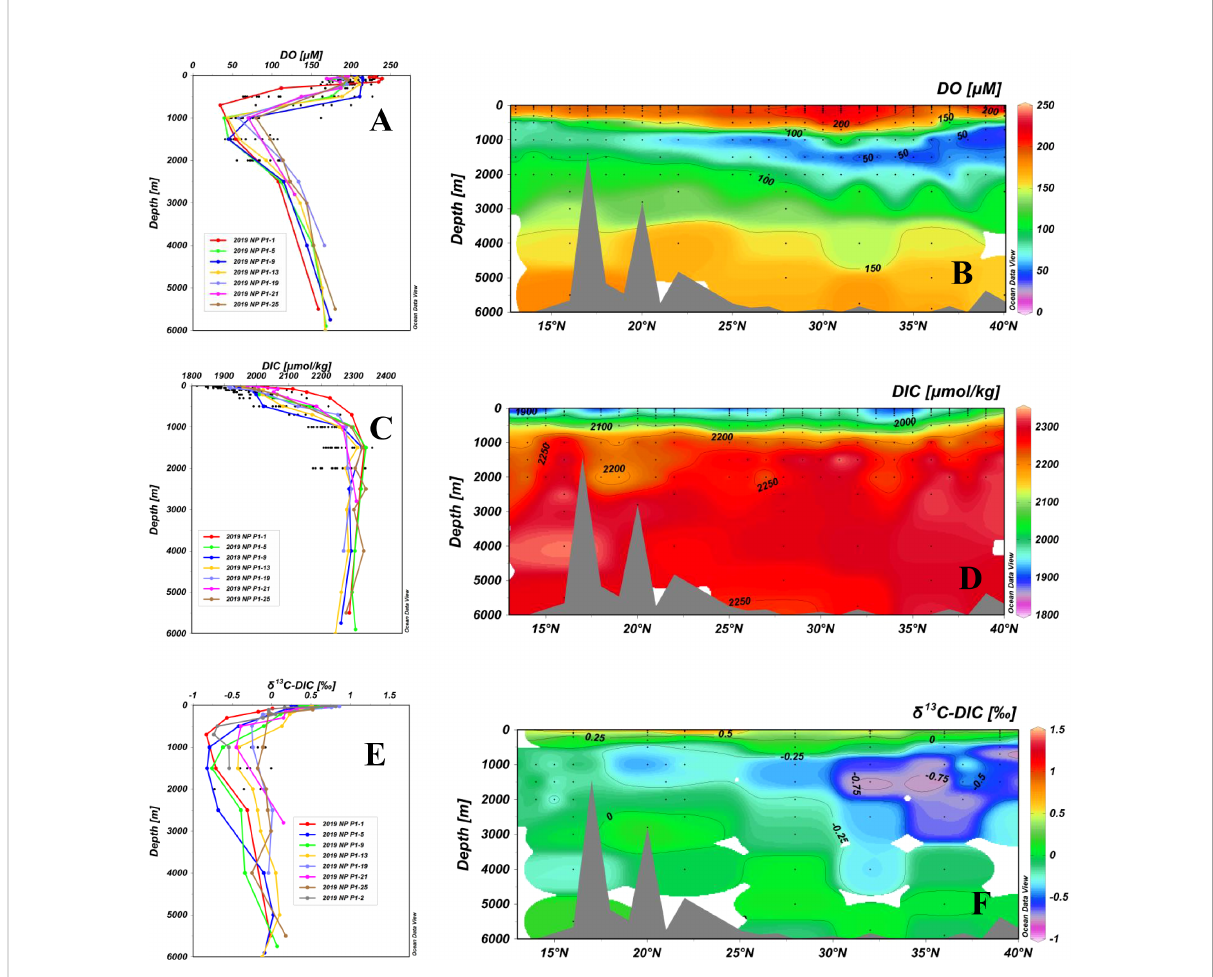
FIGURE 3 Depth pro fi les and latitudinal distributions of DO (A, B) , DIC (C, D) and d 13 C (E, F) in water samples collected from stations along the P1 transect in the northwestern NP in November 2019. Distribution of DO along the P1 transect is cited and replotted from Ge et al. (2022b). Data from the upper 2,000 m depth of the sampling stations are shown as black dots in the depth pro fi